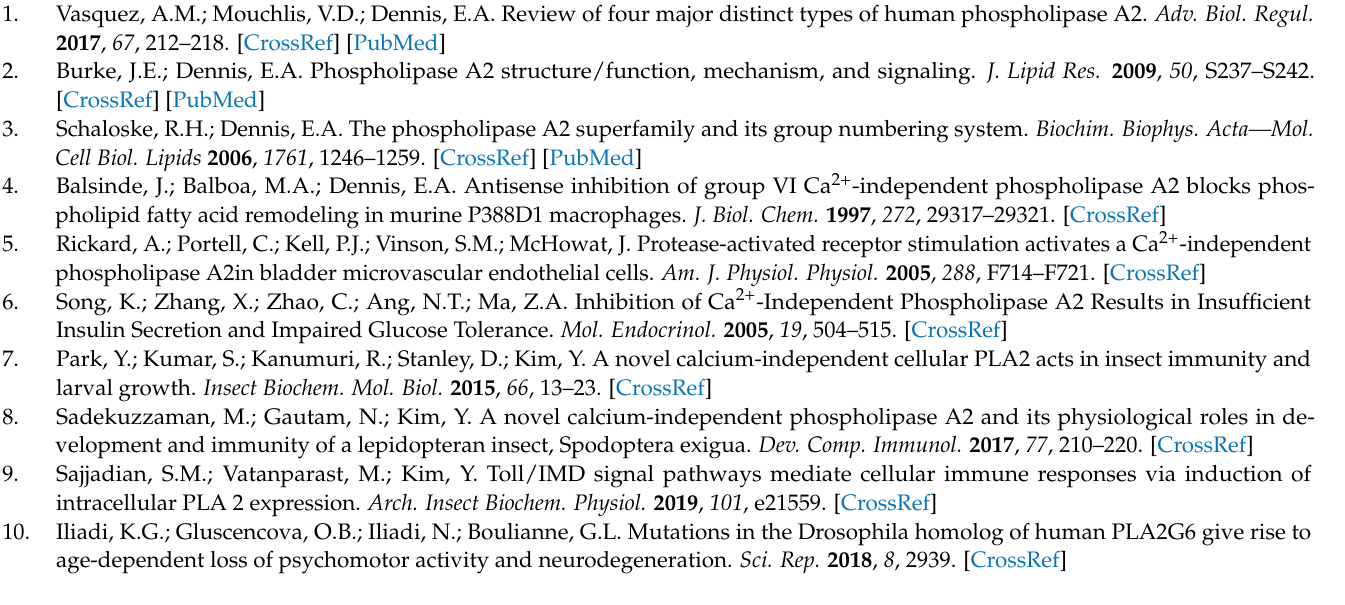
BmiPLA2A gene. Figure S2: Nucleotide and amino acid sequence of the Bombyx mori BmiPLA2B gene. Figure S3: Alignment of the BmiPLA2A protein with other homologous proteins. Figure S4: Alignment of the BmiPLA2B protein with other homologous